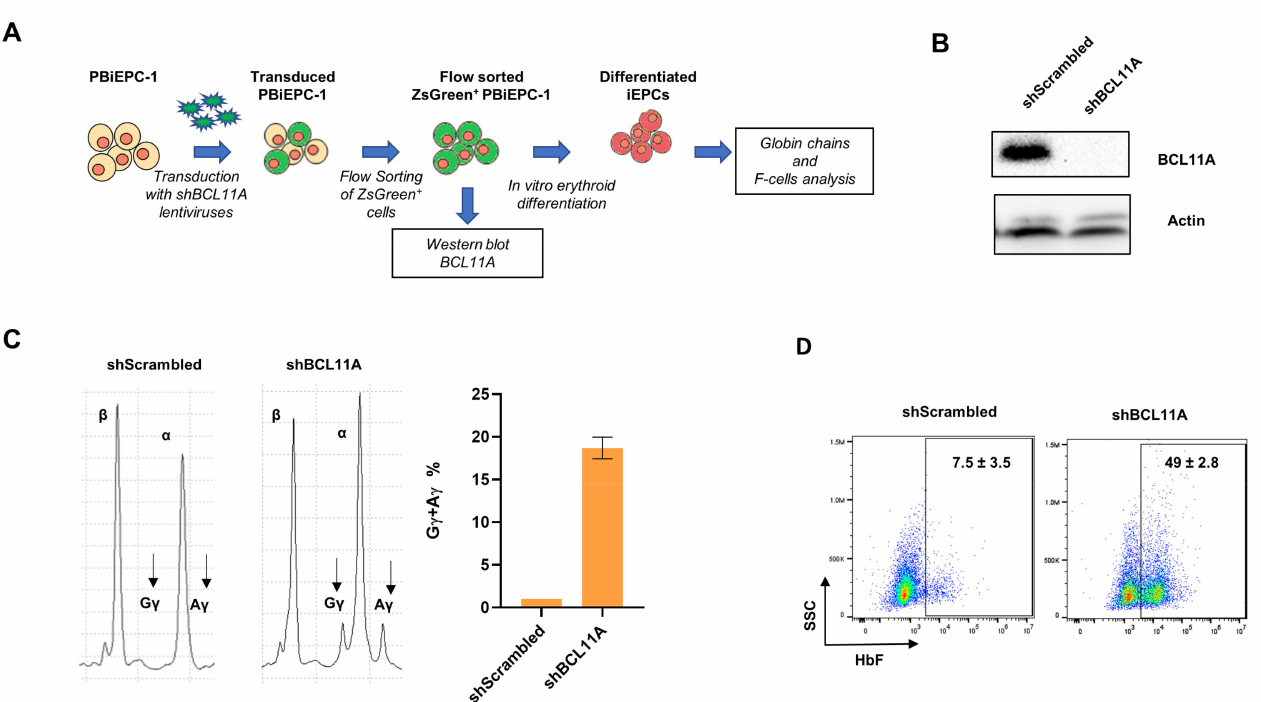
Figure 4. Knockdown of BCL11A in PBiEPC-1. ( A ) Schematic representation of the experimental setup for BCL11A knockdown in PBiEPC-1. ( B ) Western blot analysis of BCL11A knockdown in PBiEPC-1. Data were compared with the cells transduced with the scrambled shRNA. ( C ) (Left) An HPLC chromatogram showing β , α , G γ , and A γ globins in the cells transduced with shBCL11A and shScrambled lentiviruses. (Right) G γ + A γ % in the differentiated erythroid cells transduced with shBCL11A and shScrambled lentiviruses. ( D ) Flow cytometry analysis of F-cells after knockdown of BCL11A . Numbers indicate mean ± standard deviation (SD) from two independent